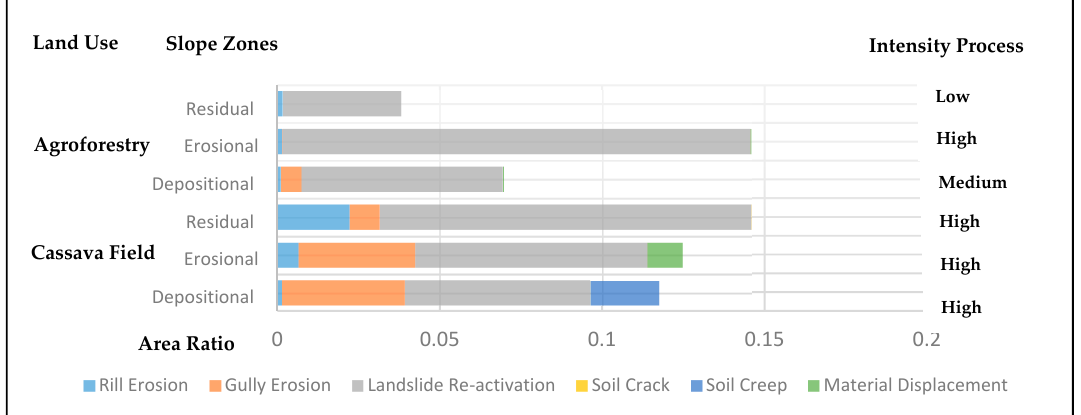
Figure 4. The ratio of geomorphological process areas in each land surface morphological zone of agroforestry and cassava field.